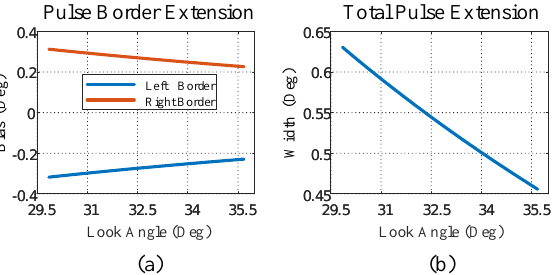
Figure 10. ( a ) The border of the pulse extension angle. ( b ) The pulse extension angle. Considering a narrowband ( B r / f 0 (cid:28) 1) DBF-SAR system with N equidistant channels in elevation, the DBF weights are time-varying in fast time. For a single snapshot, the DBF processing can be modeled as